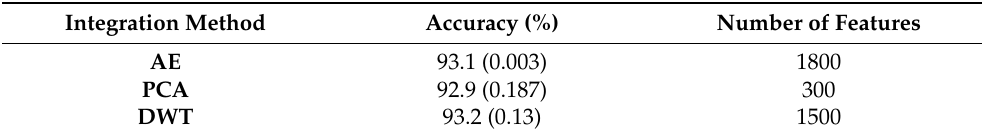
Table 6. A comparison between the highest accuracy (%) with variance and the number of features achieved using each feature integration